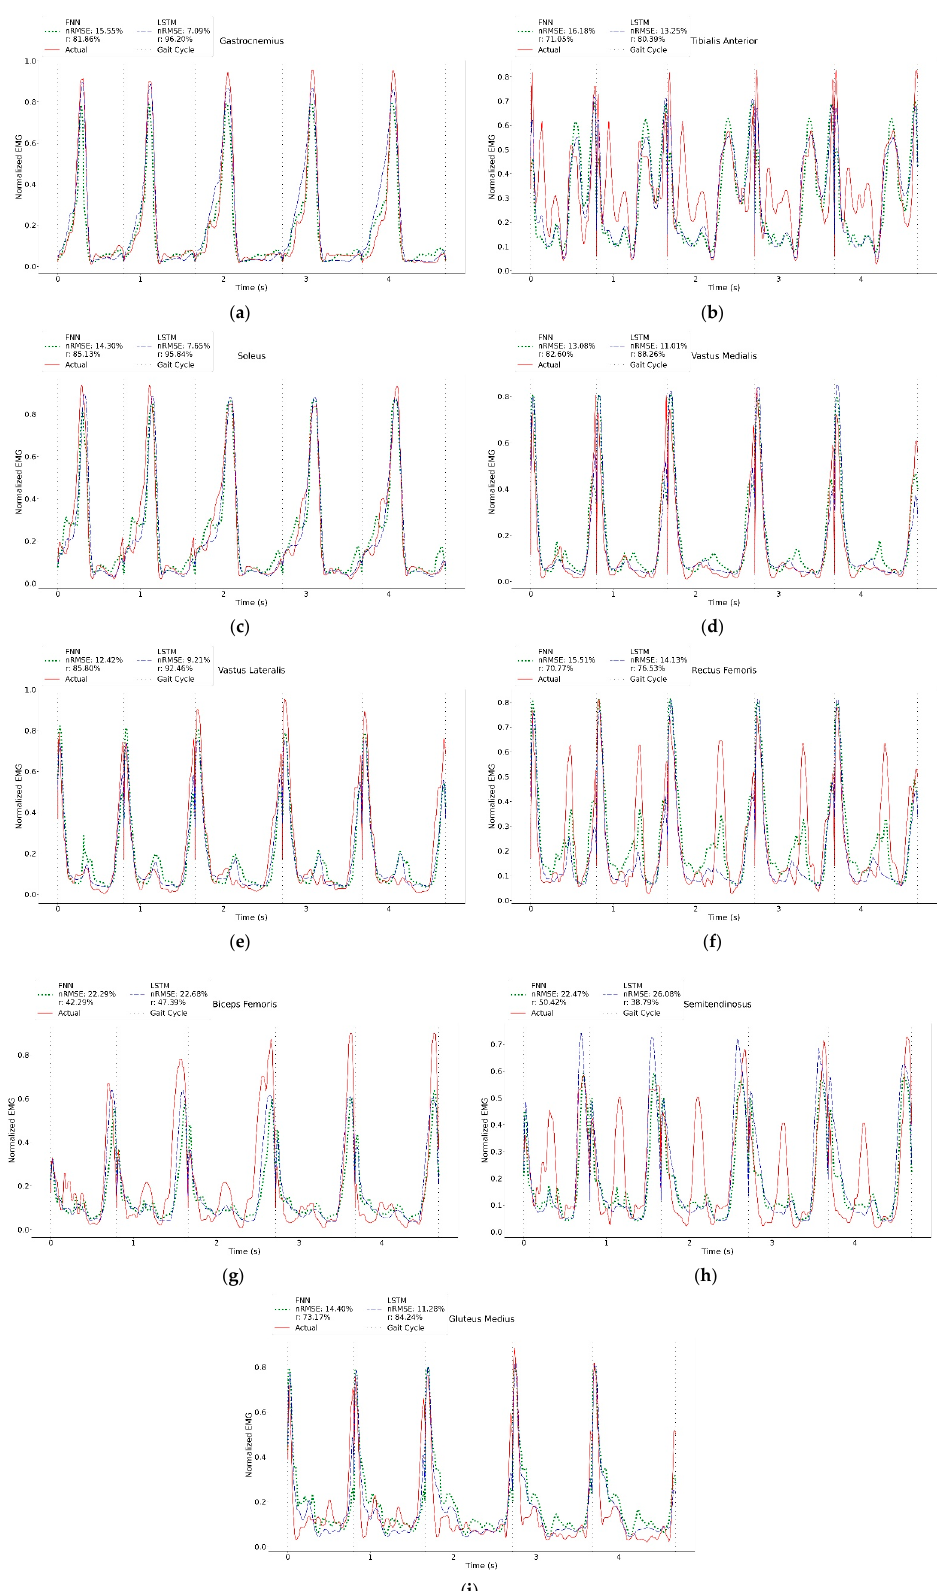
Figure 5. A sample plot of actual vs. predicted muscle activities of the unseen data of ( a ) gastrocnemius, ( b ) tibialis anterior, ( c ) soleus, ( d ) vastus medialis, ( e ) vastus lateralis, ( f ) rectus femoris, ( g ) biceps femoris, ( h ) semitendinosus, ( i ) gluteus medius.